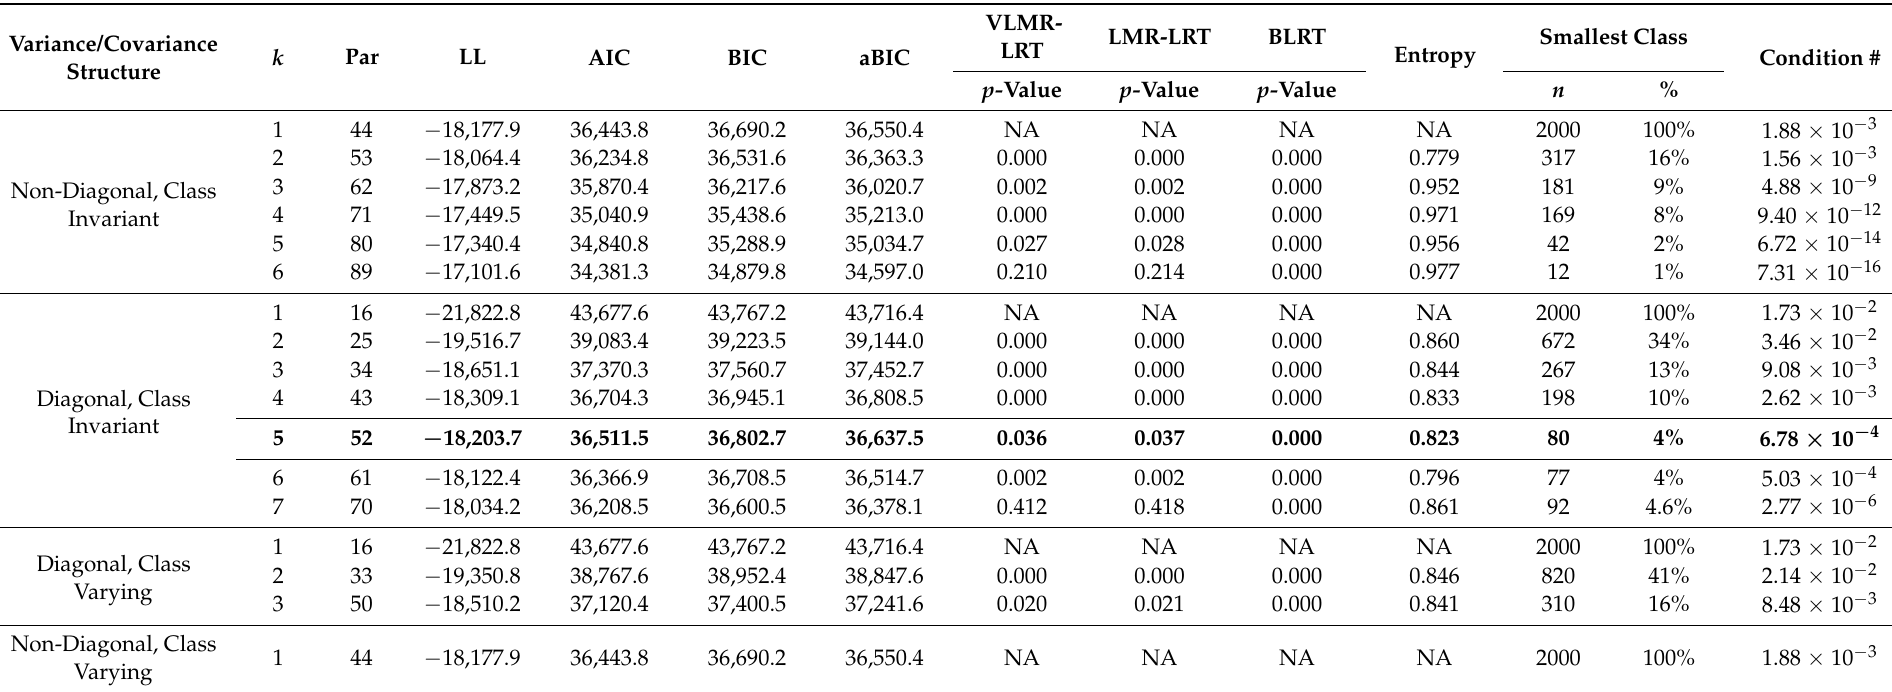
Table 4. Fit Indices for Unconstrained Post-COVID LPA Models for Each Variance–Covariance